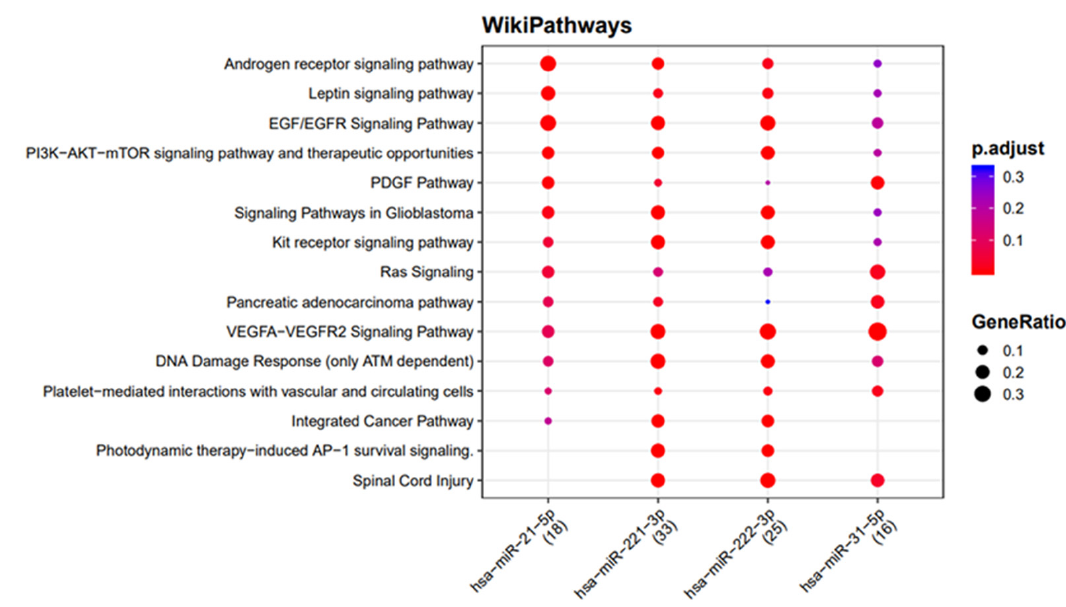
Figure 5. Functional enrichment of miRNA target genes using the WikiPathways database. The colors of the circles represent the adjusted p -values (FDR), whereas their size represents the number of miRNA targets found to be annotated in each category over the total number of recognized targets (indicated in round brackets).